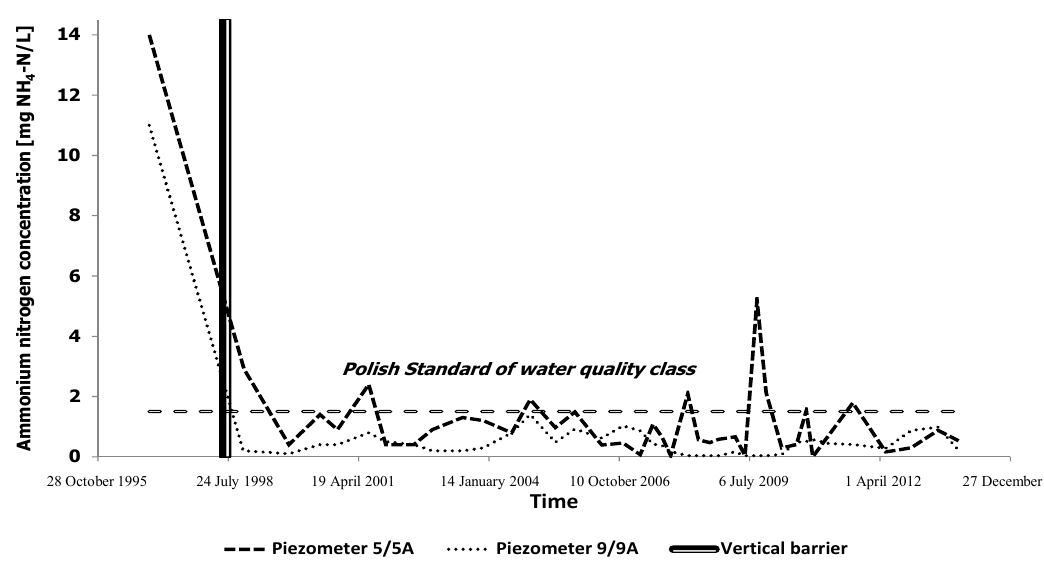
Figure 7. Changes of NH 4+ concentration on Lubna Landfill in piezometers 5A and 9A.